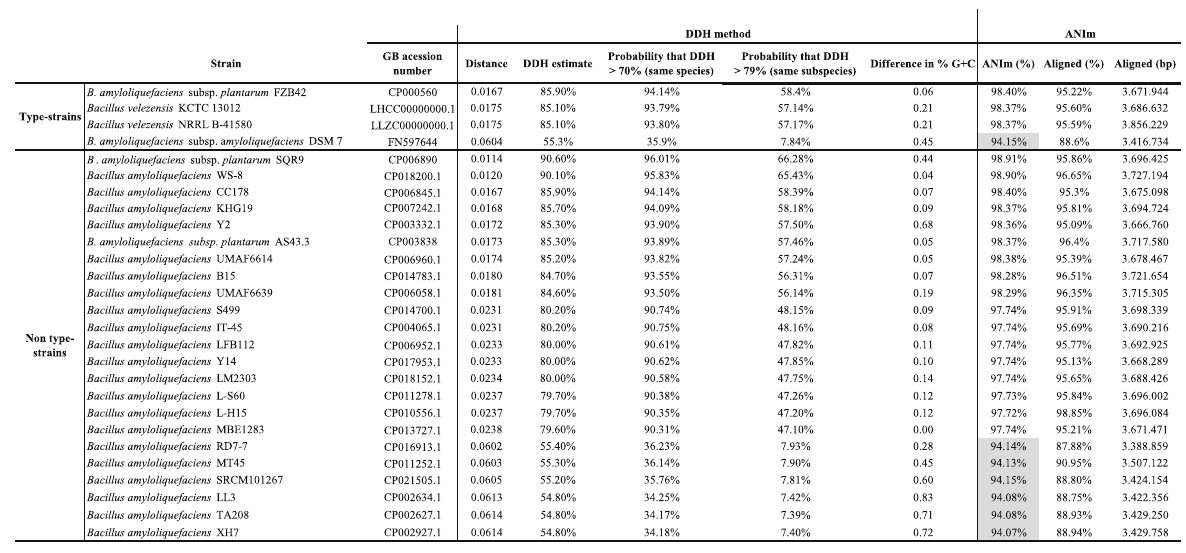
The nucleotide sequences were download from GenBank and the respective accession numbers are shown in the table. In-silico DNA-DNA hybridization (DDH) was calculated by using the Genome-to-Genome Distance Calculator (GGDC 2.1) [67] and ANI values were computed through pairwise genome comparison by using the MUMmer software [68]. Values with grey colour are of a below cut-off